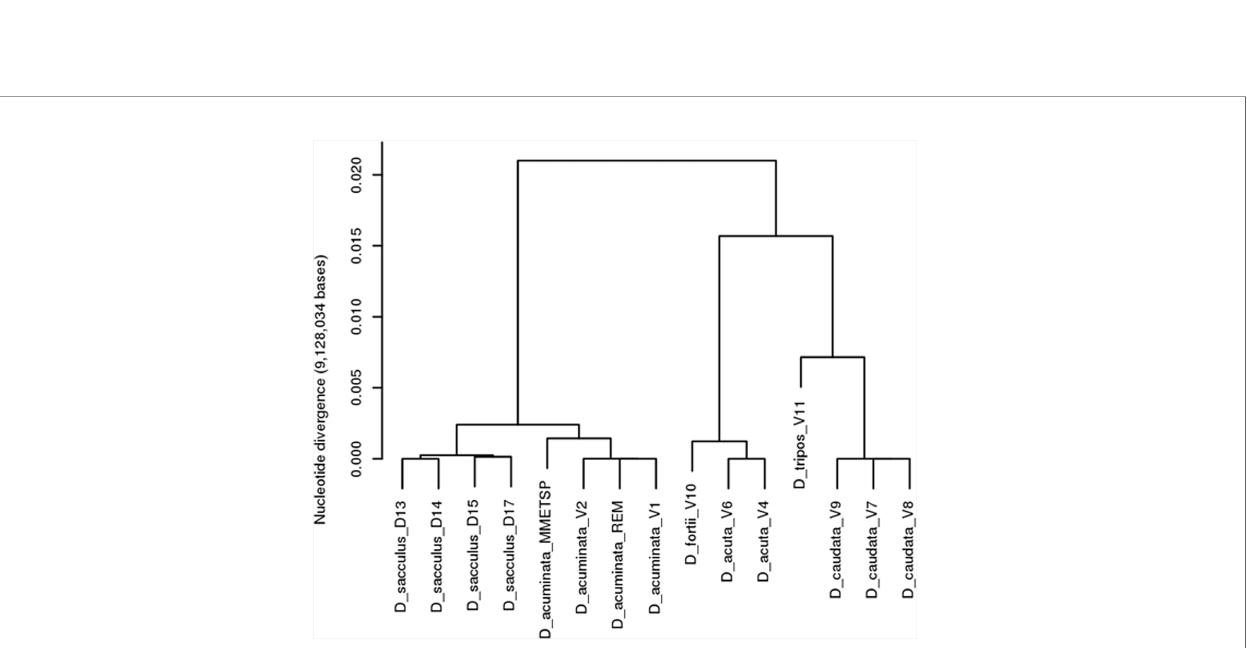
FIGURE 5 | Dinophysis connectivity matrix showing the “ mean transit time ” (days) in spring 2010, (A) Model resolution = 4km, (B) Model resolution = 1km, and in winter 2010, (C) Model resolution = 4km, (D) Model resolution = 1km.